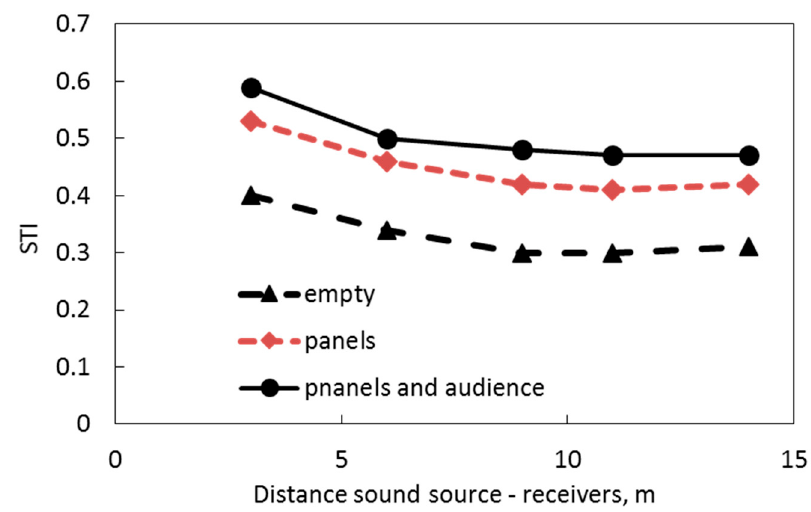
Figure 11. STI values in relation to the distances, sound source—receivers.